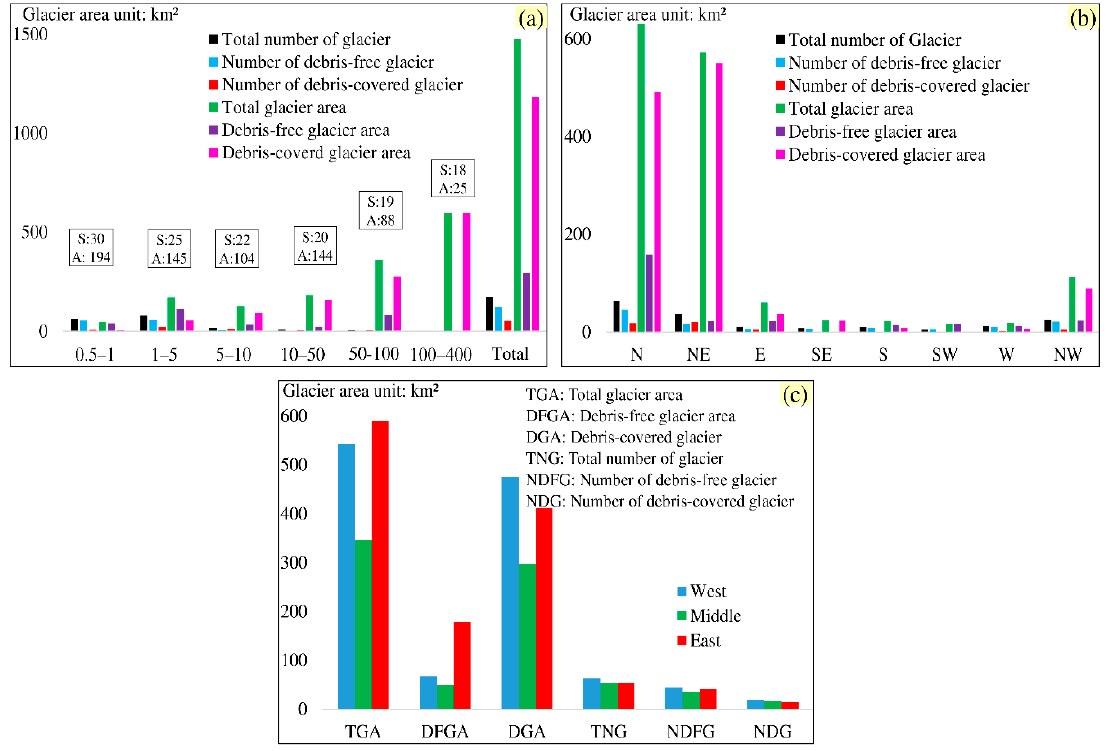
Figure 7. Diagram showing the number, area coverage for different size classes ( a ), aspect of the glaciers ( b ) and distribution of glaciers in sub-regions ( c ). In ( a ), S and A are representing the mean slope and aspect (°) value of each size classes.